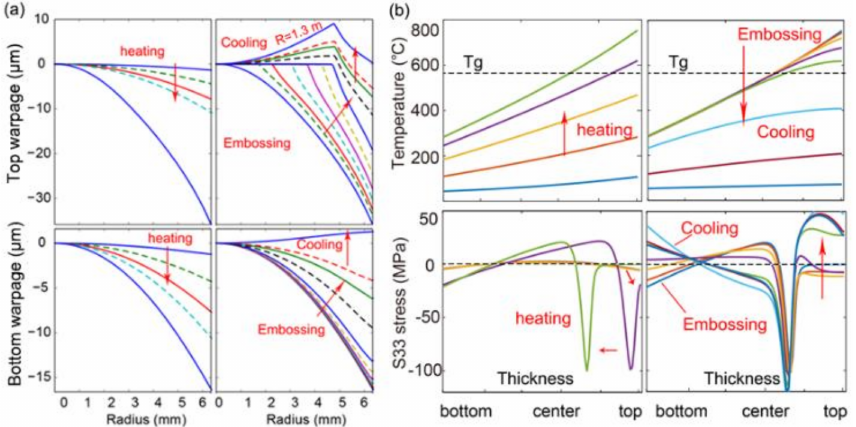
Figure 11. ( a ) Top and bottom warpage’s evolution, ( b ) temperature and hoop stress along the center line from bottom to top during the whole embossing process.